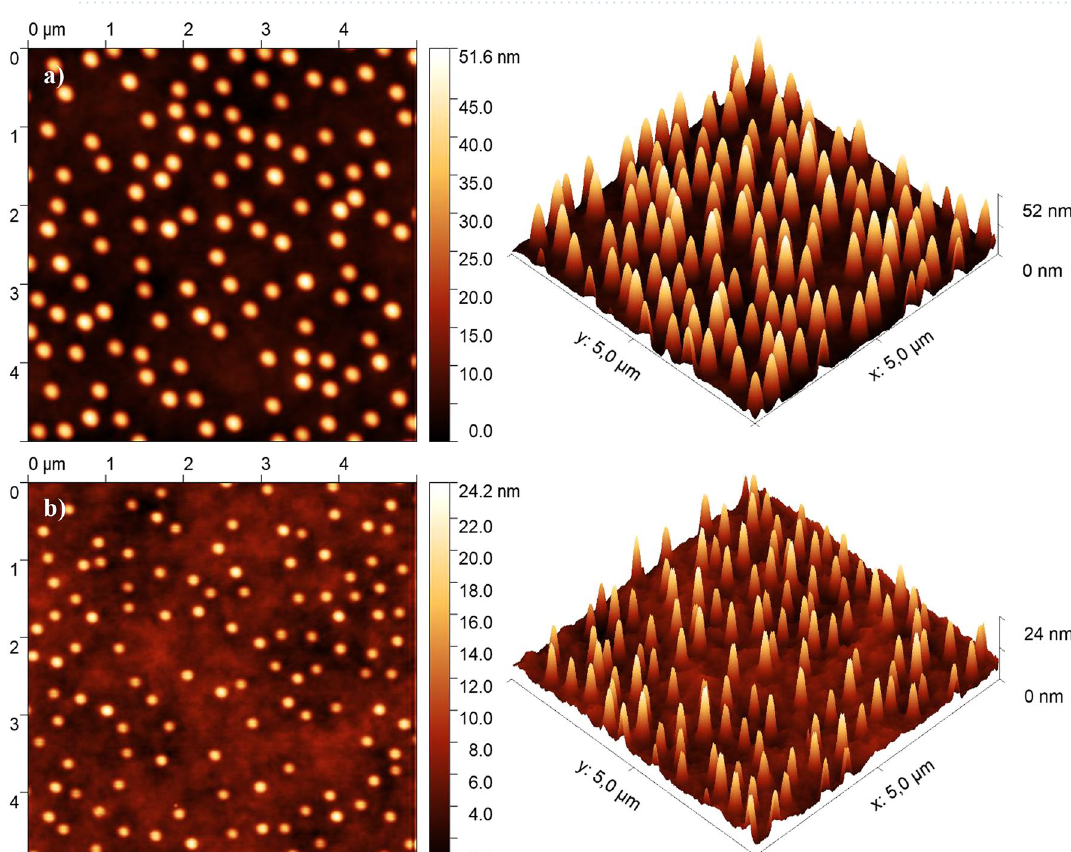
Figure 5. AFM images of the ( a ) big and ( b ) small imprinted nanopillars on the